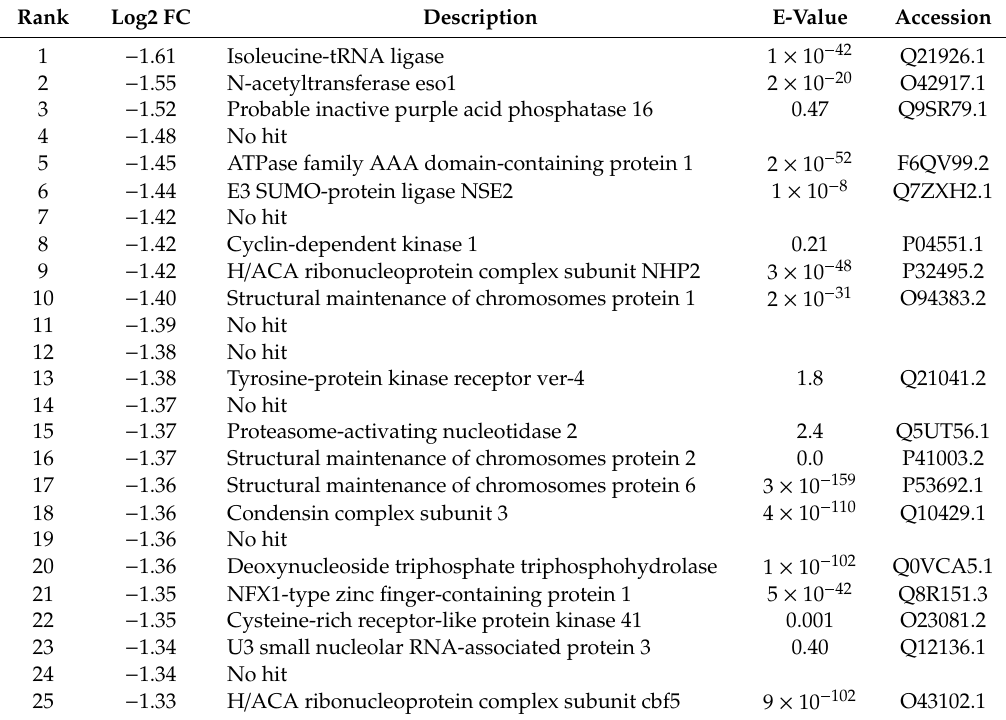
Table A3. Top 25 down-regulated transcripts of Inonotus obliquus library in library of cells cultivated in presence of